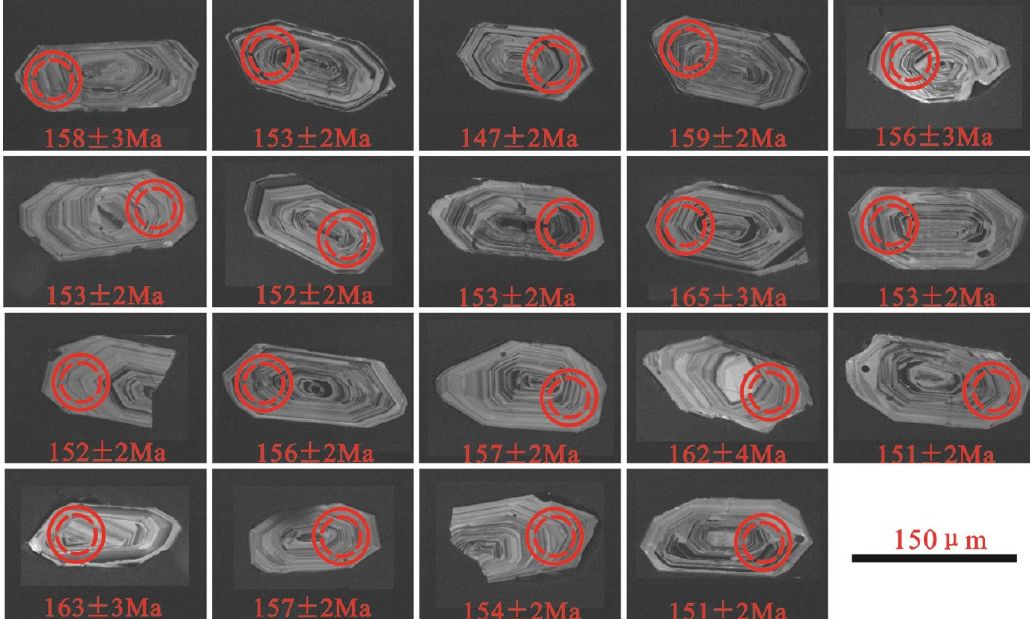
Figure 6. Cathodoluminescence images of zircon grains collected from the No. 3 granodiorite in the Shuikoushan deposit. The dashed red circles represent laser pits (~30 um) for zircon trace element and U-Pb isotopic analyses, the solid red circles represent laser pits for zircon Hf isotopic analyses (~50 um).